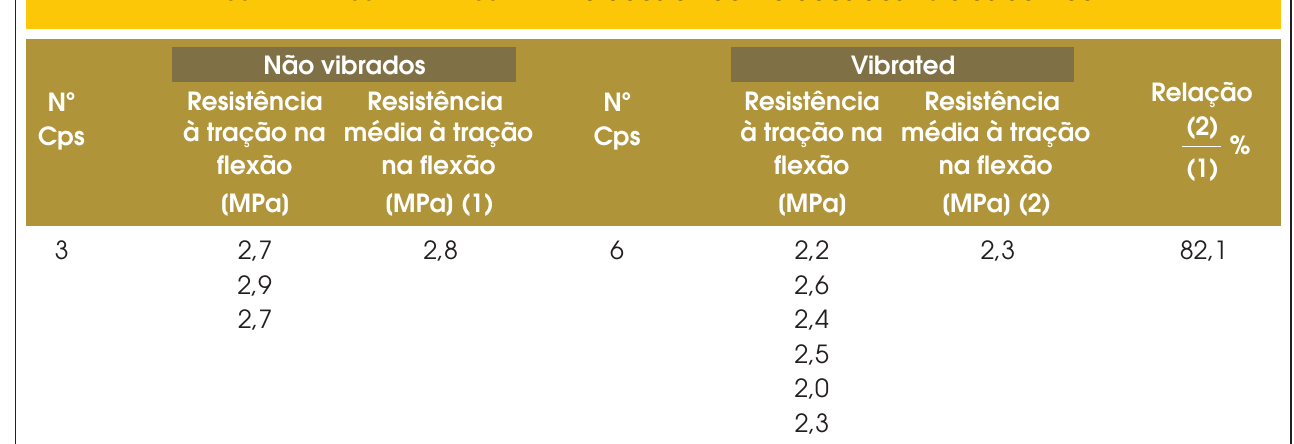
vibrados. Os valores das resistências à compressão uniaxial das amostras vibradas e não vibradas foram praticamente as mesmas. A Tabela 7 contém a resistência à tração na flexão dos corpos-de-prova prismáticos 100 mm x 100 mm x 400 mm aos 28 dias de vida vibrados e não vibrados. Houve uma perda de resistência à tração na flexão dos A Tabela 8 contém o módulo de elasticidade dos corpos-de-prova cilíndricos 100 mm x 200 mm aos 28 dias de vida vibrados e não vibrados. Houve uma perda de 10 % da rigidez dos concretos vibra - dos nas primeiras três horas de vida em relação aos não vibrados.